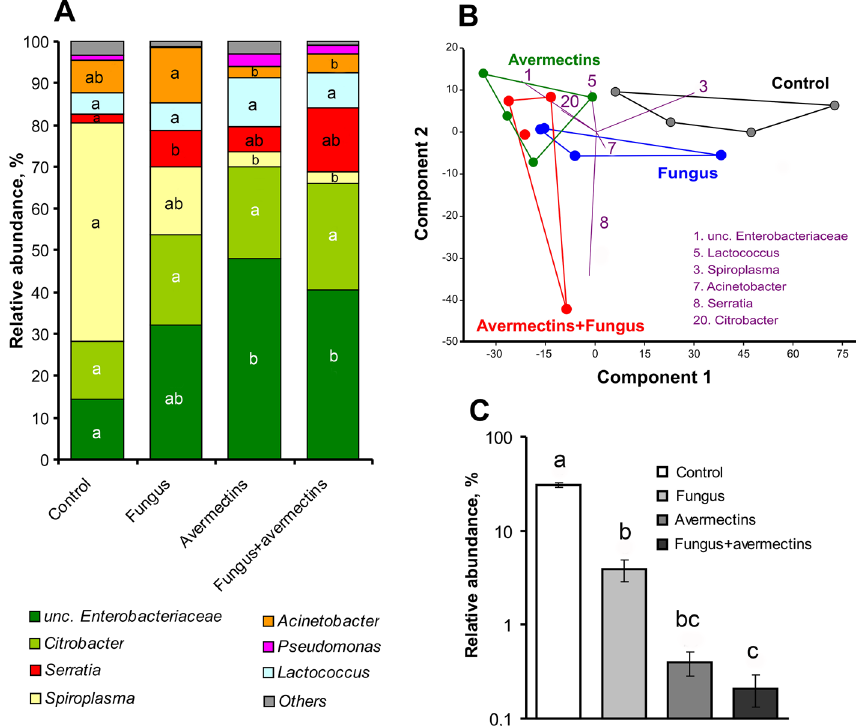
Figure 3. Alterations in bacterial communities in the midgut of Colorado potato beetle larvae at 48 h after topical treatment with M. robertsii conidia, oral administration of avermectins and the combined treatment. ( A ) Microbiota structure at the genus level, ( B ) PCA at the OTU level, with numbers indicating the predominant OTUs. ( C ) Changes in chloroplast 16S DNA relative abundance. Different letters indicate significant differences in taxa abundance between treatments (Dunn’s test, P <